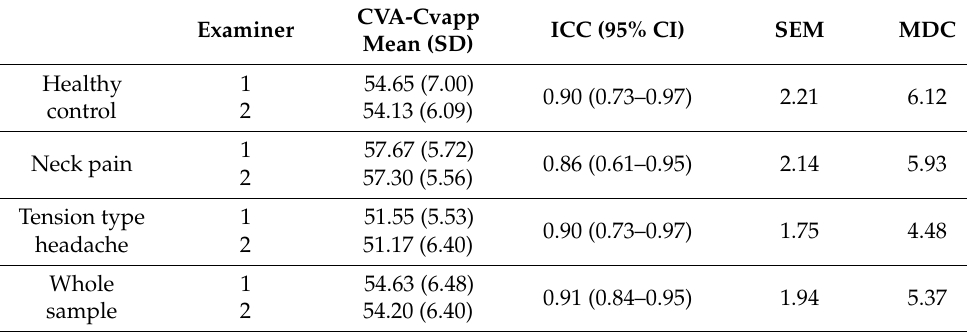
Table 3. Inter-rater reliability for subgroups and the whole sample.